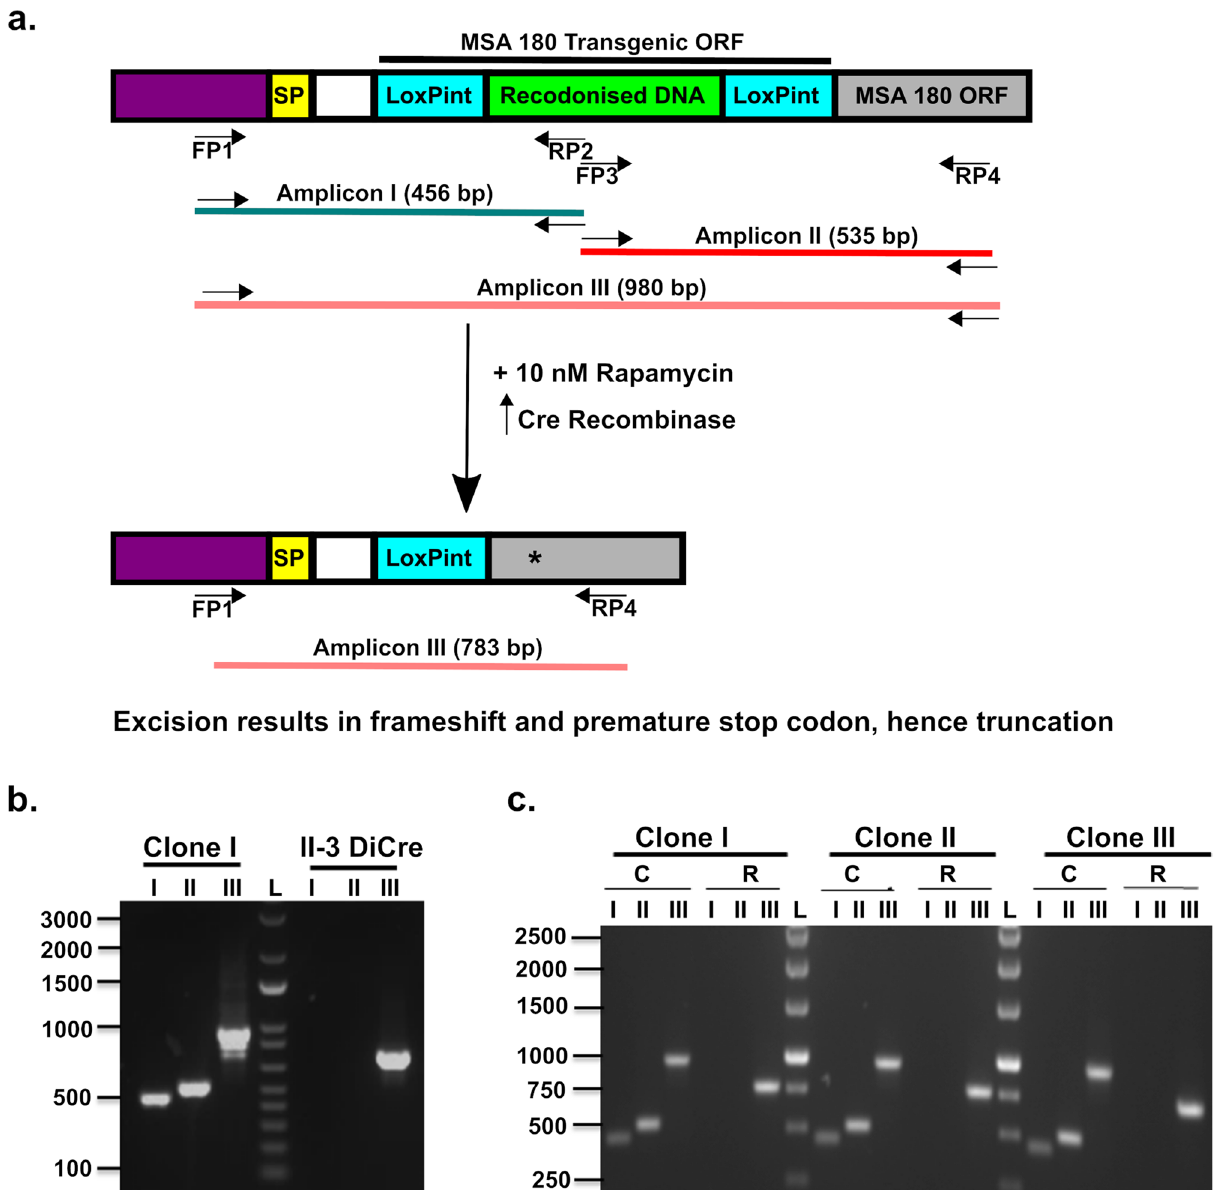
Figure 5. Generation of parasite lines to perform inducible knockout of the pfmsa180 gene. ( a ) Schematic diagram of the expected amplicons with different primer pairs. The recondonised DNA between the two LoxPint sites was used to differentiate the transfected (PfMSA180) and wild type (II-3 DiCre) parasite lines. SP- Signal peptide, FP- Forward Primer, RP- Reverse primer, *premature stop codon after successful recombination, LoxPint- LoxP sites in sera2 intron. Predicted amplicon I (456 bp) was amplified with primer pairs 1/2, Amplicon II (535 bp) was amplified with primer pairs 3/4, Amplicon III was amplified with primer pairs 1/4 and the size depended on rapamycin treatment (without rapamycin/DMSO treated, 980 bp; after rapamycin treatment, 783 bp). The transgenic ORF is comprised of two LoxPint sites inserted at the 5’ end of the gene; the remaining msa180 ORF is depicted by grey box. Not to scale. ( b ) PCR to confirm transfection and insertion of repair sequence. Lane1- Amplicon I (Primers 1/2), Lane 2- Amplicon II (Primer 3/4), Lane 3- Amplicon III (Primers 1/4) from pfmsa180 inducible knockout clone (980 bp) and from wildtype II-3 DiCre parasites (774 bp). PCR results shown for one of three pfmsa180 inducible knockout parasite clones. PfMSA180 transgenic line – the presence of a band in Lane 1 and 2 of MSA180 confirms integration of the repair sequence containing two LoxPint sites into the parasite genome. Lane 3 confirms the presence of unmodified msa180 sequence in wildtype parasites. ( c ) PCR analysis of DNA excision after rapamycin treatment for all three inducible msa180 knockout clones. Early ring-stage parasites were treated with 10 nM rapamycin and the growth medium was changed after 24 h without adding further rapamycin. L- DNA Ladder, Lane1-Amplicon I (Primers 1/2), Lane 2-Amplicon II (Primer 3/4), Lane 3-Amplicon III (Primers 1/4). DMSO-treated PfMSA180 (control)—980 bp, Rapamycin-treated—783 bp. Absence of bands in lanes 1 and 2 following rapamycin treatment confirms successful gene excision. Full length picture of the agarose gel showing PCR product bands and DNA ladder can be found in Supplementary Fig.